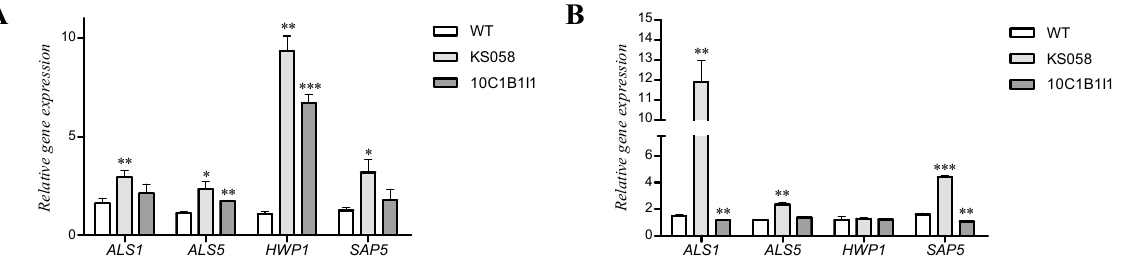
Figure 4. Relative expression of genes encoding adhesins ( ALS1, ALS5, HWP1, SAP5 ) determined for C. albicans WT (SC5314), KS058 ( erg11 Δ / Δ ) or 10C1B1I1 ( ERG11 K143R / K143R ) strains after 8 h ( A ) or 24 h ( B ) of culture in YPD medium ( n = 3; ±SD). Results obtained for KS058 or 10C1B1I1 strains were compared to the WT strain for certain adhesin genes (*, p < 0.05; **, p < 0.01; ***, p < 0.001). In the case of the C. albicans KS058 strain, we observed higher expression of all inves- tigated genes encoding adhesins after 8 h of culture in the YPD medium (Figure 4A). For C. albicans KS058, the highest expression was detected for the HWP1 gene (about a 10-fold increase in relative HWP1 expression). The C. albicans 10C1B1I1 strain exhibited signifi- cantly increased expression of ALS5 and HWP1 genes, while the HWP1 expression was six-fold higher than for the WT strain after 8 h of culture. After 24 h of culture in YPD medium, the expression of ALS5 and HWP1 genes de- creased compared to 8 h of culture and is similar for all investigated strains, except the two-fold higher expression of ALS5 for C. albicans KS058 compared to the WT strain (Fig- ure 4B). Interestingly, the ALS1 gene expression after 24 h was significantly higher than after 8 h of culture for KS058 (a 10-fold increase compared to the WT strain). Additionally, we determined the adhesins gene expression profile in C. albicans WT (SC5314), KS058 and 10C1B1I1 strains after co-culture with NHDF and VK2 E6/E7 cell lines. The results are presented in Figure 5.